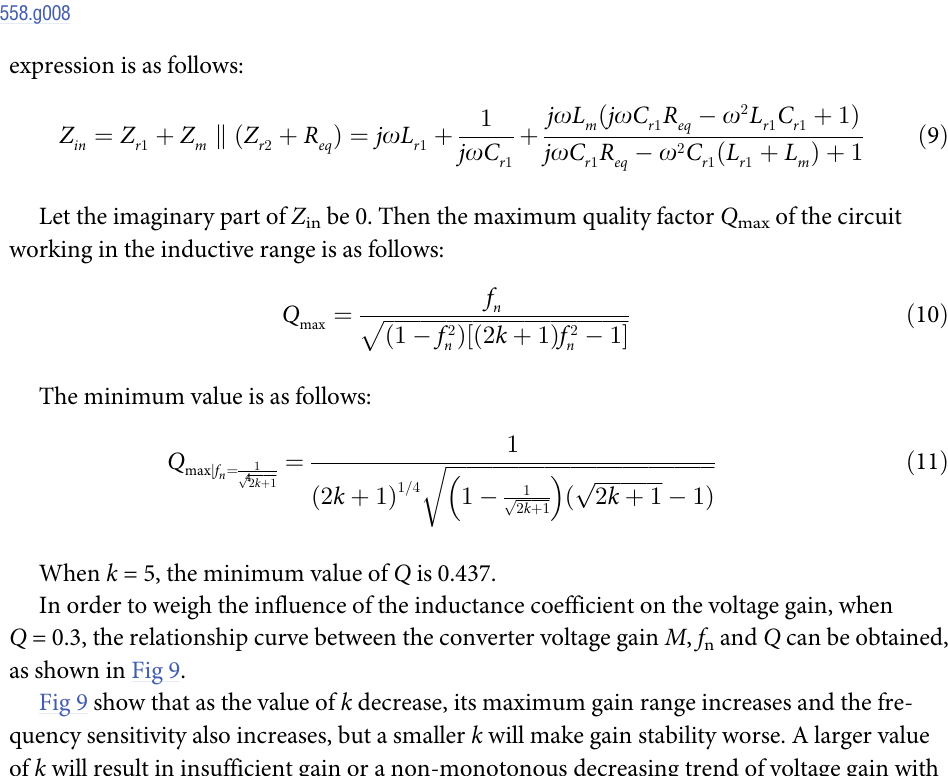
Fig 8. Voltage gain